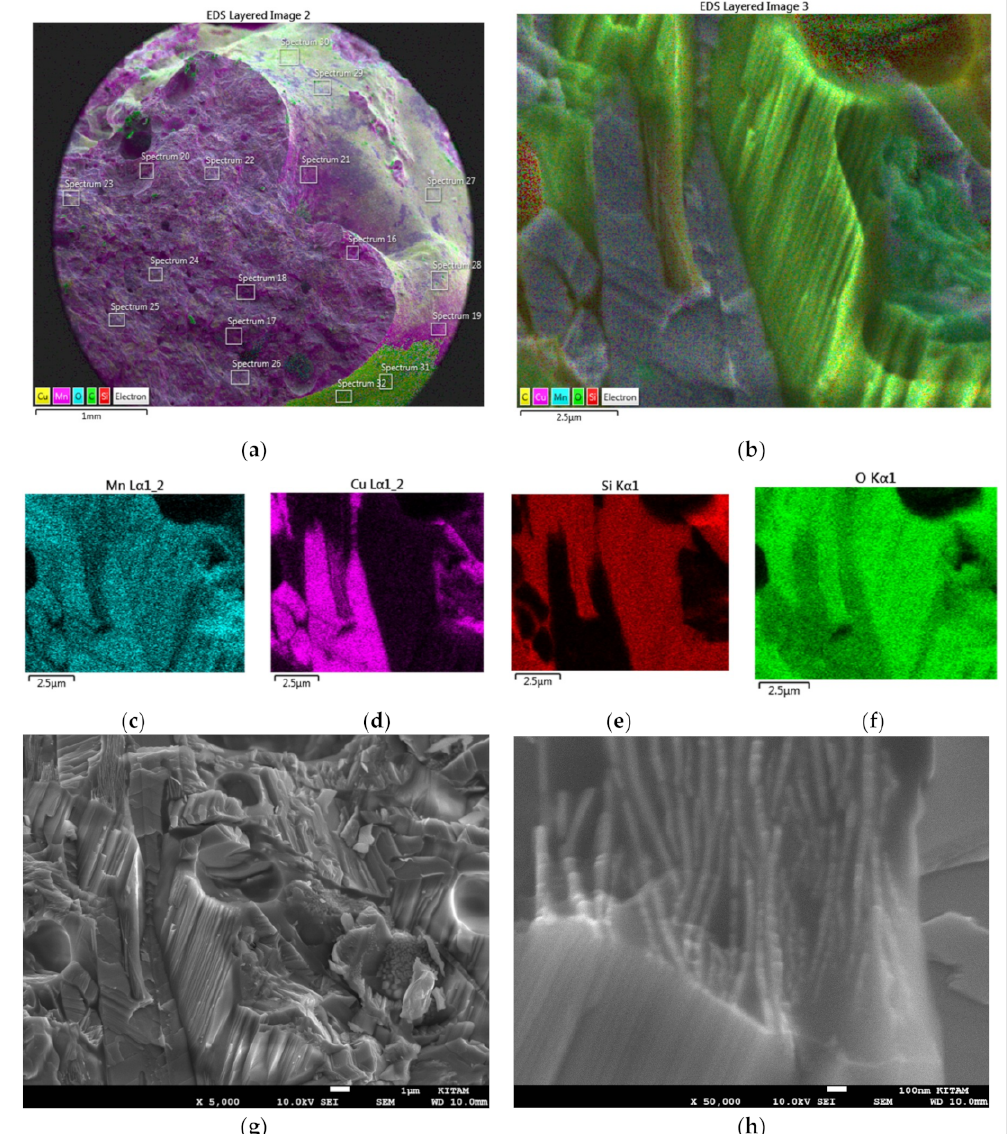
Figure 34. Structure of Mn / Cu / Si = 1.5 / 0.5 / 1 catalyst as evaluated by EDS and SEM analysis. ( a ) EDS image of a catalyst particle at low magnification showing the existence of Cu-rich and Mn-rich domains with molar composition: [Mn] = 0.217, [Cu] = 0.181, [Si] = 0.118, [O] = 0.484 (scale bar = 1mm); ( b ) EDS image of the Cu-rich region at high magnification with molar composition: [Mn] = 0.343, [Cu] = 0.115, [Si] = 0.123. [O] = 0.419 (scale bar = 2.5 µ m); ( c ) Mn-mapping; ( d ) Cu-mapping; ( e ) Si-mapping; ( f ) O-mapping; ( g ) SEM image of the EDS mapped area in ( b ) (scale bar = 1 µ m); ( h ) SEM image of the ca. 35 nm thick plates forming a rectangular shaped layered structure shown in images ( b , g ) (scale bar = 100